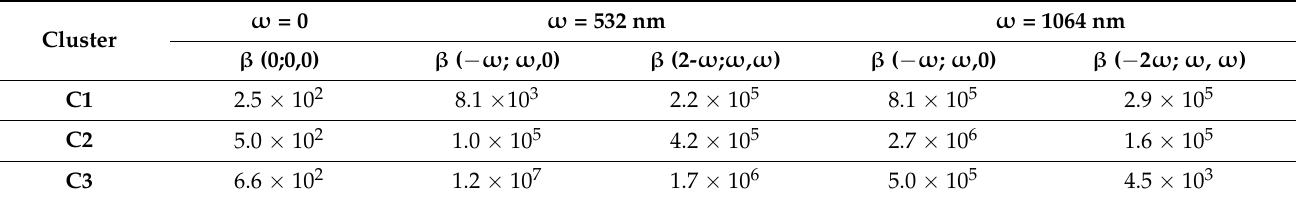
Table 5. Hyperpolarizability ( β 0 in au), frequency-dependent hyperpolarizability β ( ω ) in terms of